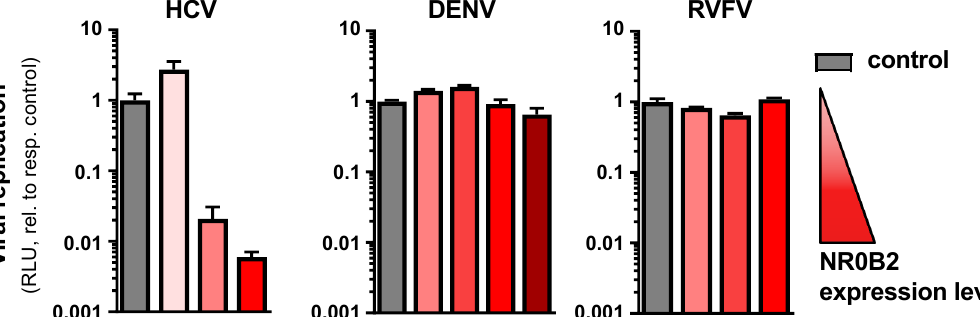
Figure 7. NR0B2 specifically a ff ects HCV replication. Huh7-Lunet cells overexpressing di ff erent levels of NR0B2 (see Figure 6B) were infected with HCV, DENV, or RVFV luciferase reporter viruses, respectively. Luciferase activity was measured after 72 h for HCV and 48 h for DENV and RVFV, respectively. Note the logarithmic y